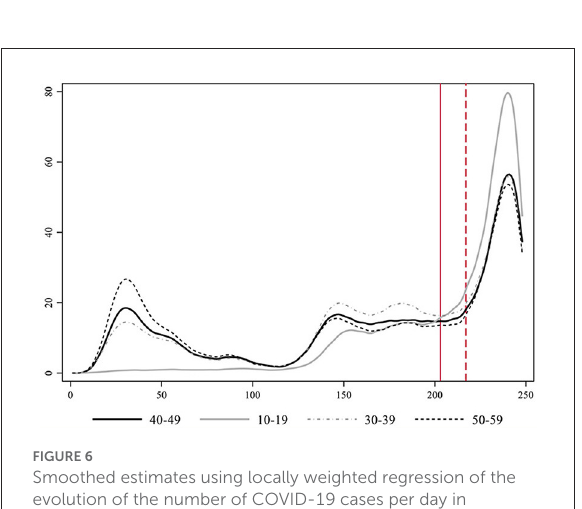
FIGURE6 Smoothed estimates using locally weighted regression of the evolution of the number of COVID-19 cases per day in Catalonia by specific age-groups.